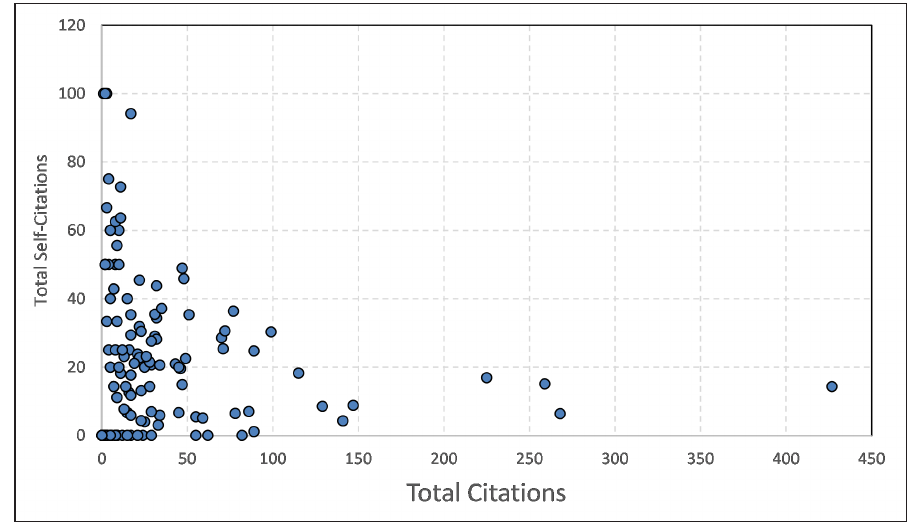
Figure 4: Self-citations for the CS papers in this study. The total number of self-citations to the 143 CS papers is com- pared to the total number of all citations to each